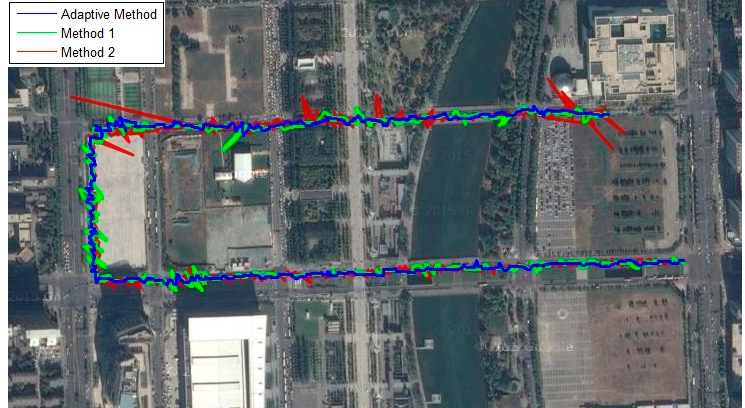
Figure 27. The output of PD (l eft ) and the corresponding PLI ( right ) for SV6.